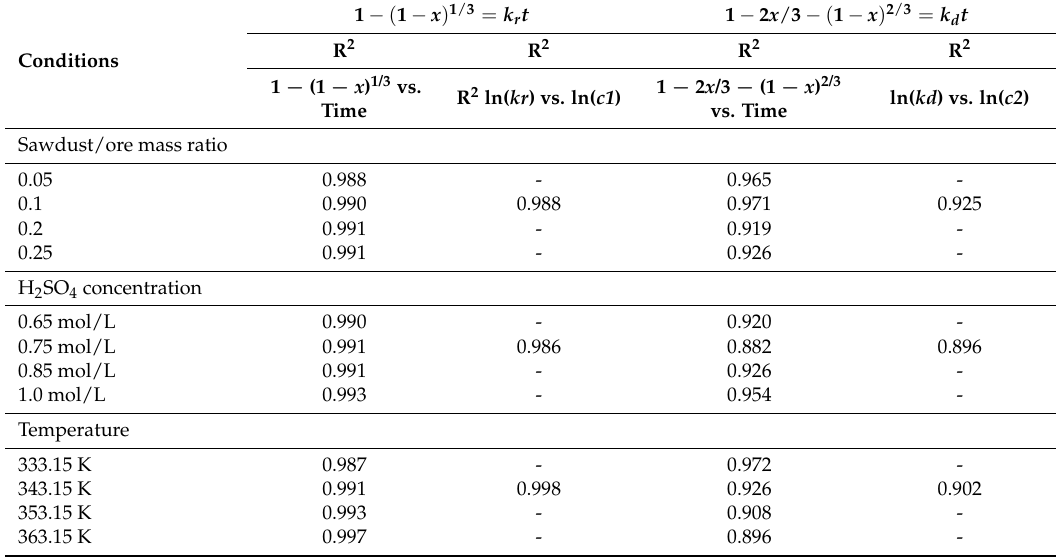
Table 3. Correlation coefficients (R 2 ) of the kinetic models in different conditions.